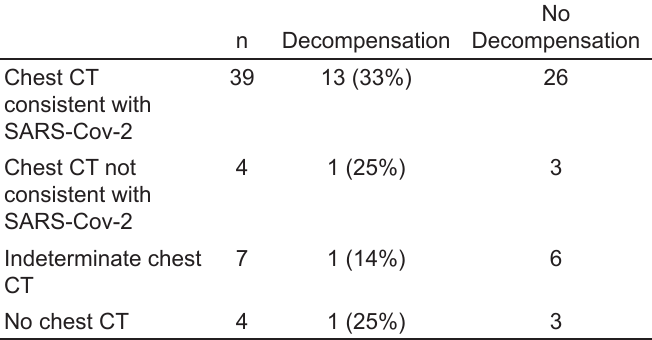
Table 5. COVID-19 patients with normal chest radiographs (n =